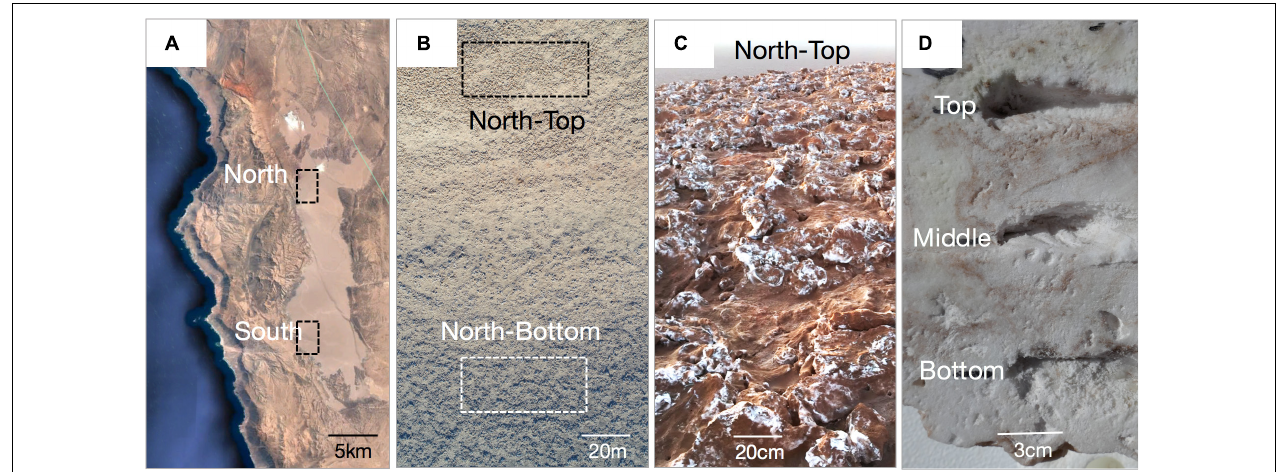
FIGURE 1 | (A) Google Earth view of the Salar Grande with the North and South sampling regions. (B) Drone image of the hill at the North site showing the sampling areas at the top and bottom of the hill (photo by Mathias Meier). (C) Halite nodules at the top of the North hill. (D) Cross-section of a halite nodule with the locations of samples taken from the top, middle, and bottom of the nodule with respect to its original orientation in the